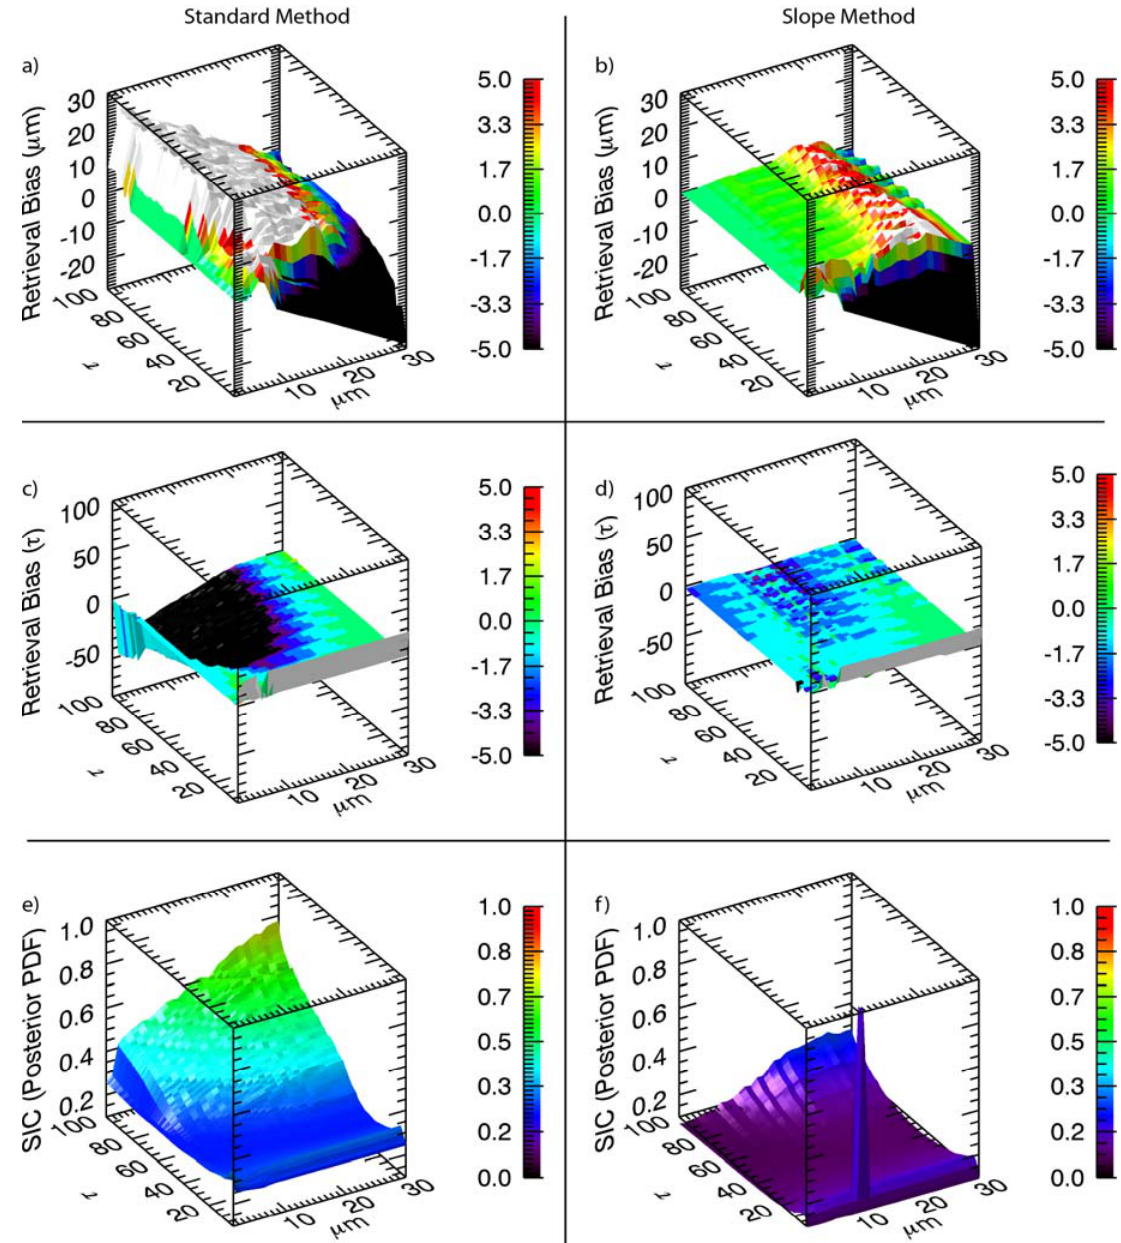
Figure 7. Surface plots of retrieval biases in effective radius and optical thickness (biases are defined as the difference between the maximum likelihood solution of the joint posterior pdf in τ and r and the true values) and the normalized Shannon information e content of the joint posterior pdf for the standard method (left column) and the slope method (right column,). Results (z-axis) are shown for a broad range in droplet effective radius (1–30 μ m, x-axis) and cloud optical thickness (1–100, y-axis). Calculations shown are for μ = 0.866, +3% systematic measurement error, and variable surface albedo from 0 bare soil to purely vegetated surface types. Colored contours are used to ease interpretation of retrieval biases ( a–d ) within ±5 in optical thickness and ±5 μ m in effective radius, where black denotes retrieval biases in excess of − 5 and white denotes retrieval biases in excess of +5. Green denotes near zero biases. In (e , f) , the color scale of the normalized Shannon information content ranges from 0 to